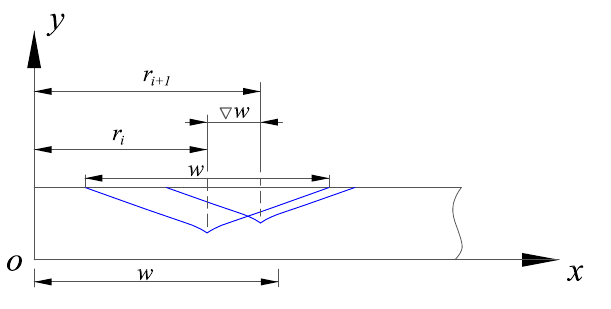
Figure 5. Section view of two adjacent grooves.